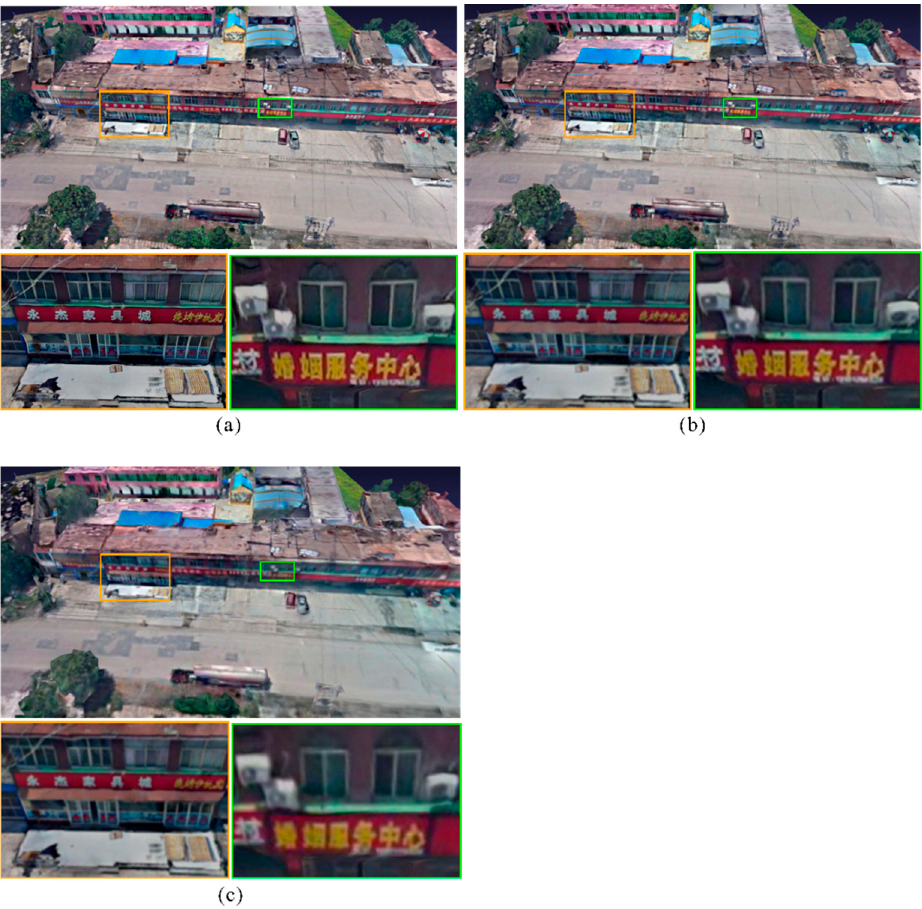
Figure 13. Texture quality comparison of the building area models. The orange and green framework in the upper overall image represent the corresponding local enlarged drawing below the overall image. ( a ) The proposed algorithm: 𝛼 = 0.50 , 𝛽 = 2.0 , number of facets = 54,651. ( b ) The proposed algorithm: 𝛼 = 0.25 , 𝛽 = 4.0, number of facets = 27,326. ( c ) The proposed algorithm: 𝛼 = 0.125 , 𝛽 = 8.0, number of facets = 13,662.